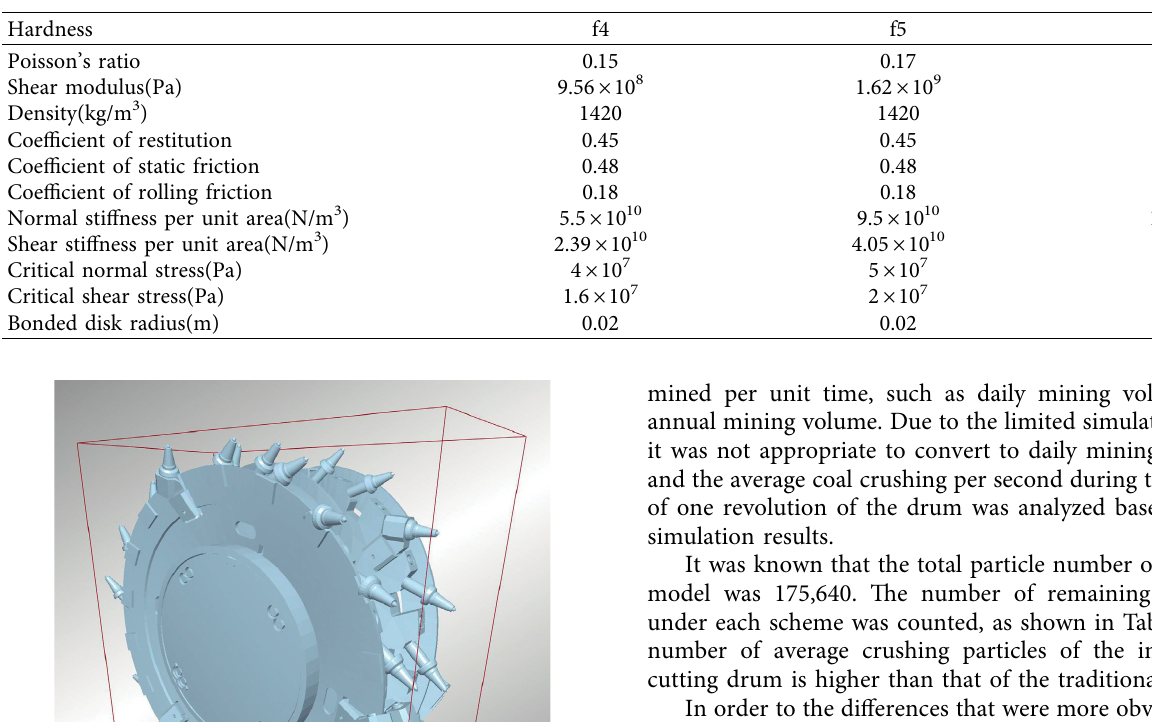
Table 1: Material parameters and bonding parameters under different hardnesses.